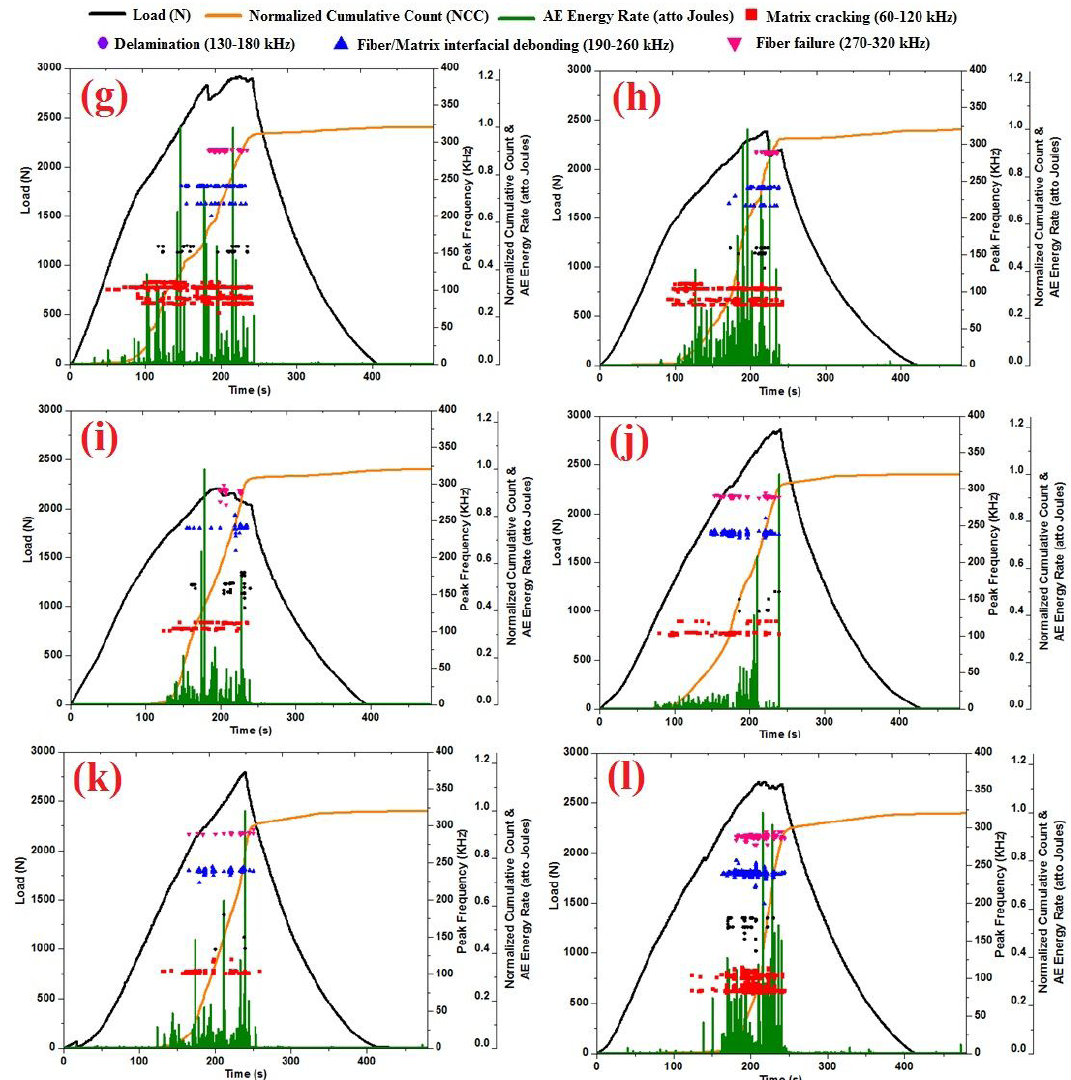
Figure 7. Representation of AE activities during indentation: (g) AP@0 o , (h) AP@10 o , (i) AP@20 o , (j) QIS@0 o , (k) QIS@10 o and (l) QIS@20 o .